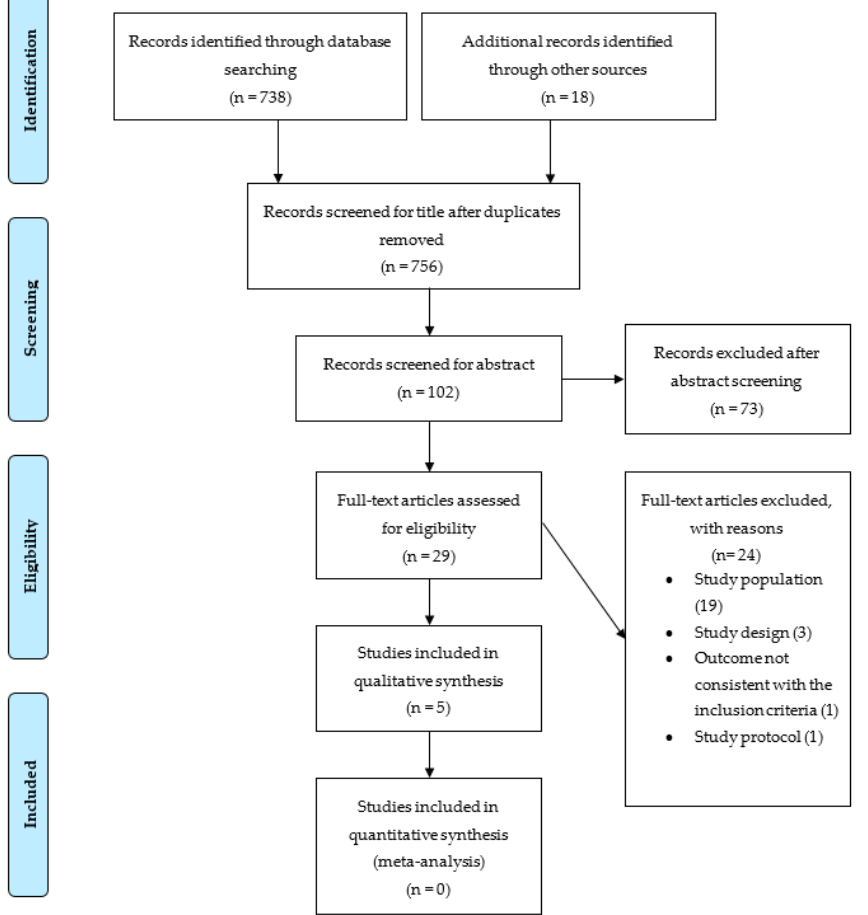
Figure 1. Flow chart of the selection process of included studies.